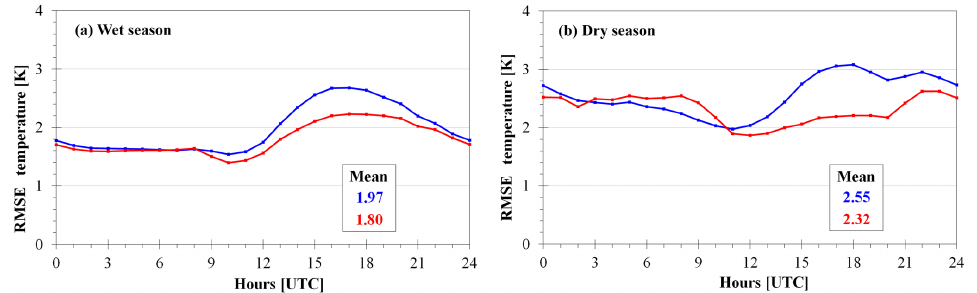
Figure 4. RMSE of air temperature at 2m using the JULES (in red) and LEAF3 (in blue) surface schemes with BRAMS over South America during (a) the wet season in March 2010 and (b) the dry season in September